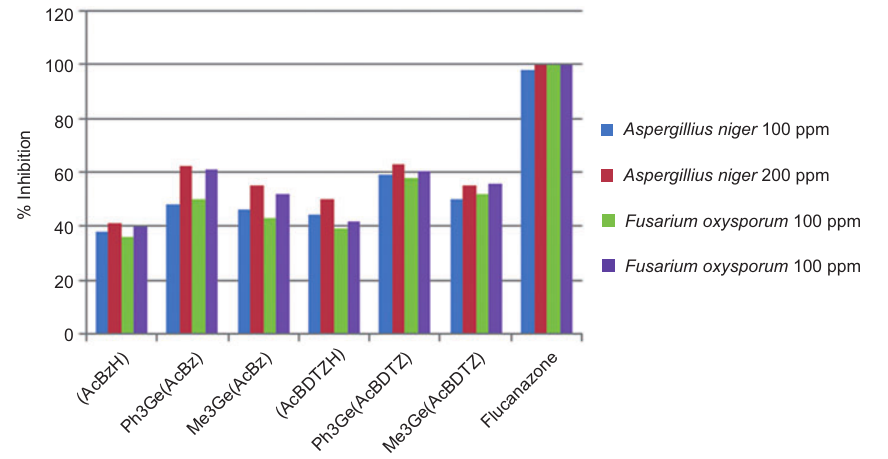
Figure 3 Antifungal screening of the ligands and their complexes.